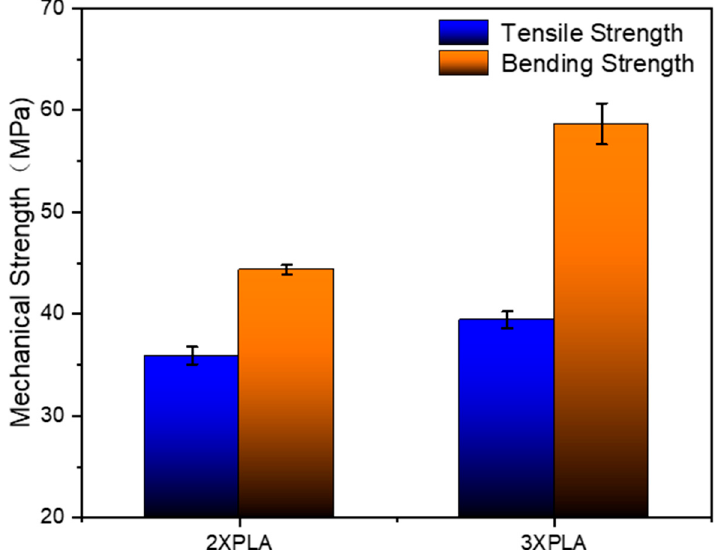
Figure 19. Mechanical strength of ultrasonic welded parts.